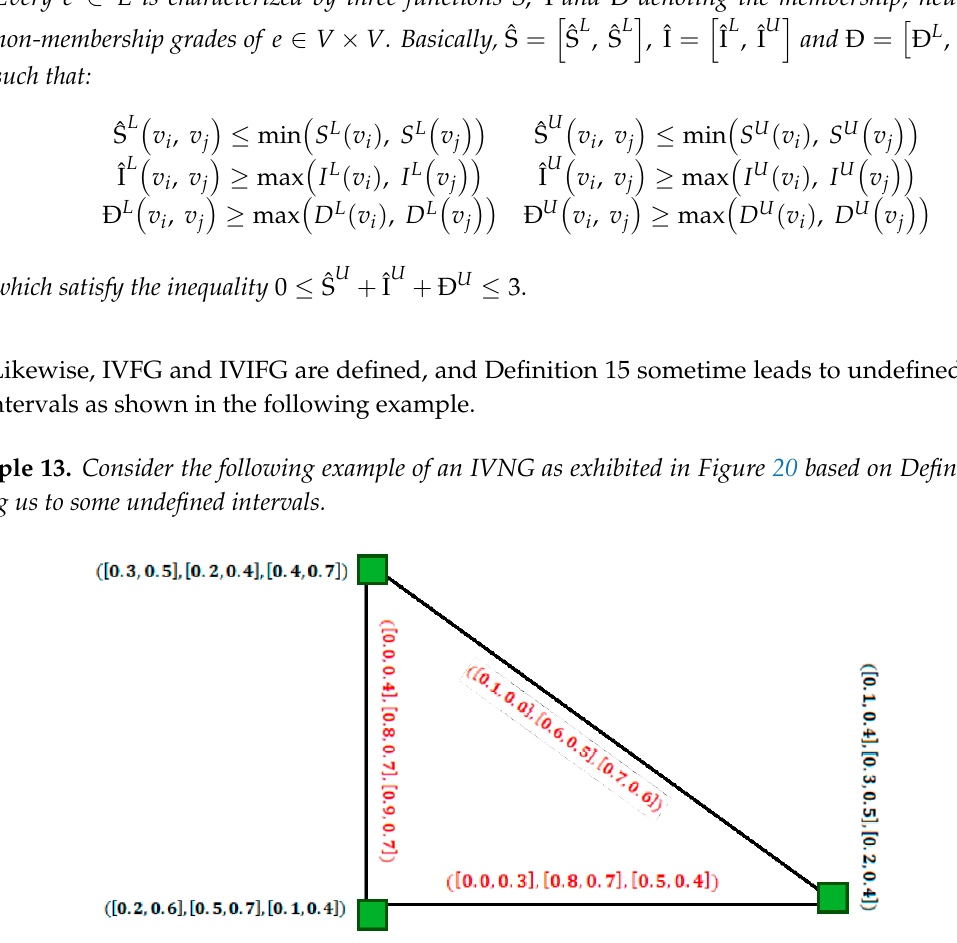
Figure 20. Interval-valued neutrosophic graph with undefined intervals.